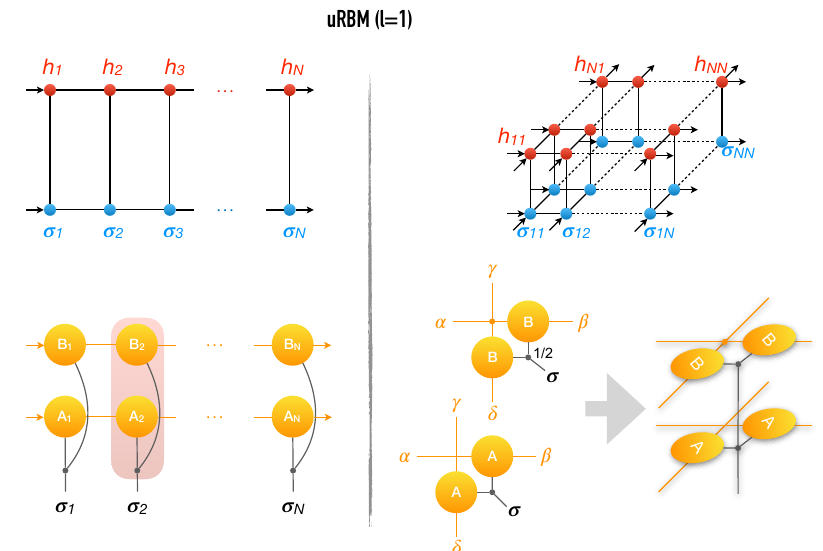
Figure 2: The uRBM with one layer of hidden variables in one (two) dimension is mapped to the corresponding coMPS (coPEPS). In the 2D case we only draw the local building block of the full tensor network. Here in general crossing lines are independent, except when a dot fixes them to be equals. The 1 / 2 in one of the dot means that the B matrices have to be evaluated at σ/ 2 (see main text for details). Arrows indicate periodic boundary